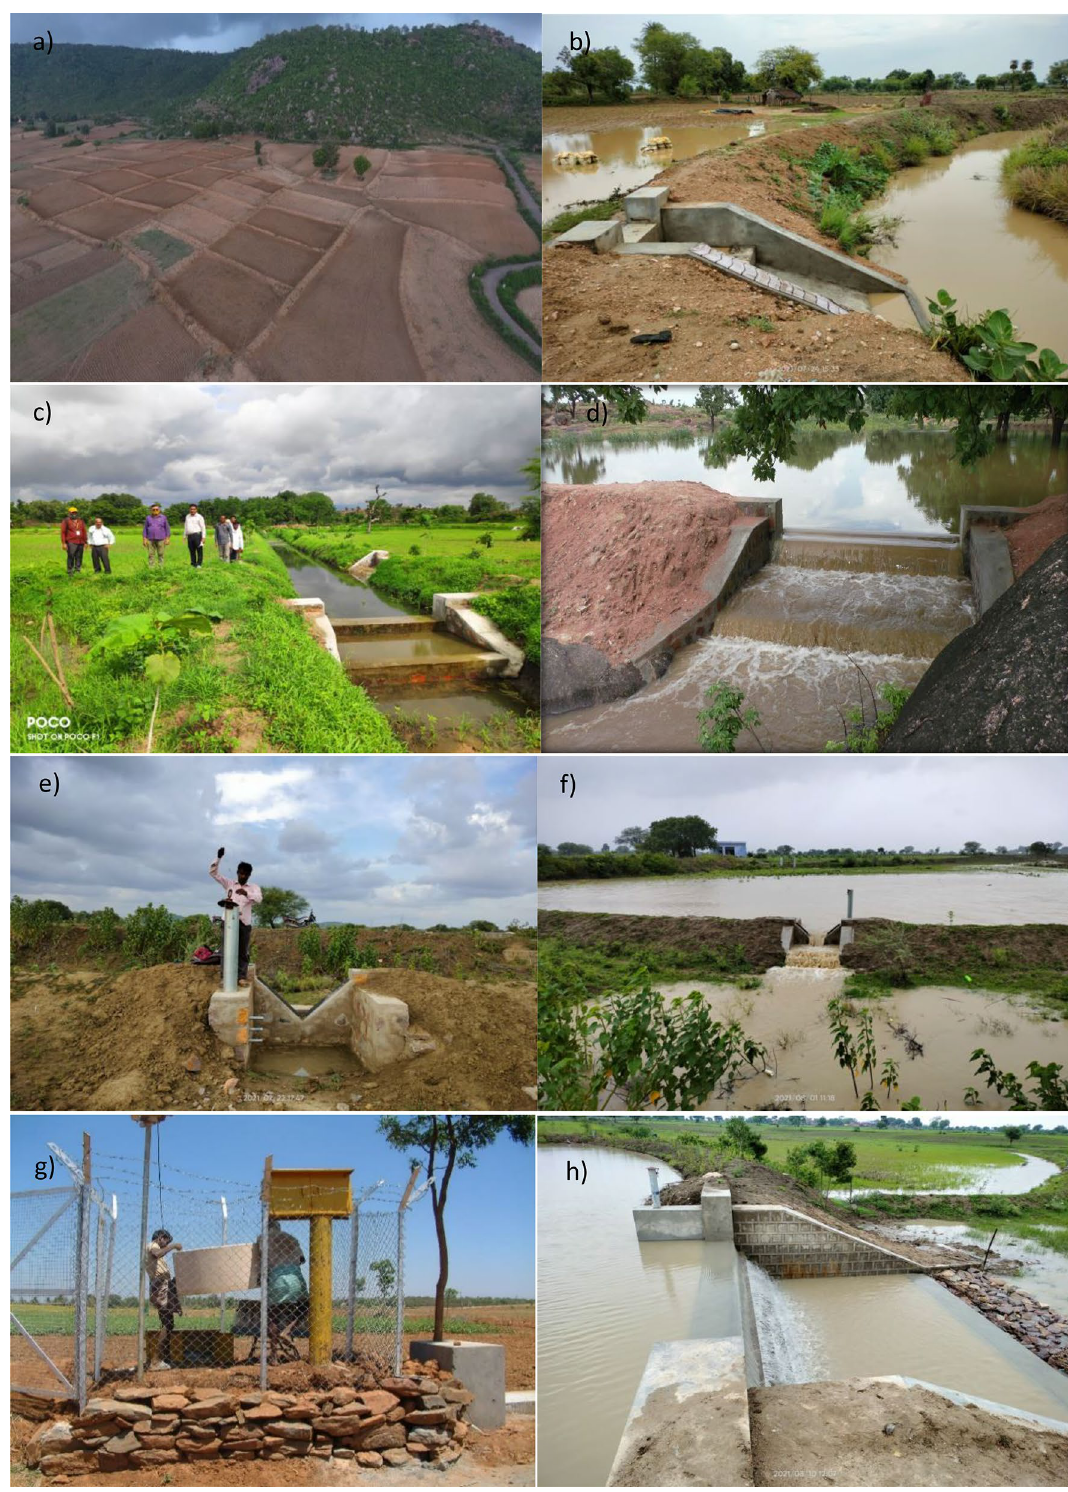
Figure 2. Different methods of rainwater harvesting and the hydrological monitoring system set up in the study watersheds: ( a , b ) In-situ and ( c , d ) ex-situ rainwater harvesting interventions and ( e – h ) hydrological monitoring gauges to estimate surface runoff and soil